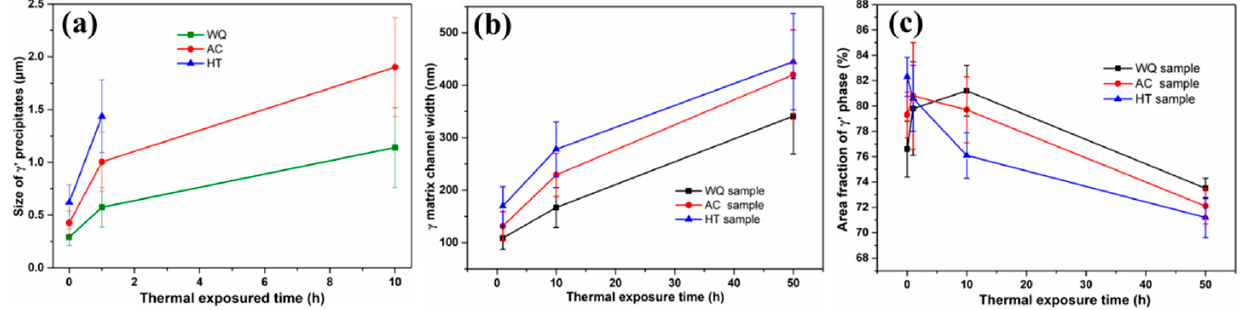
Figure 8. The Variation in the size of γ′ precipitates ( a ), width of γ matrix channel ( b ), and the area fraction of γ′ phase ( c ) in the alloys during thermal exposure at 1100 °C.